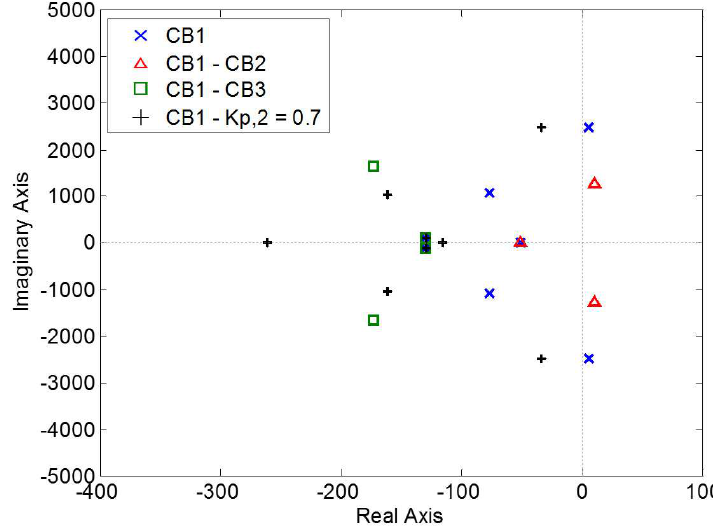
Figure 20. Poles of 1/ ( Y g + Y eq ) after CB1 is